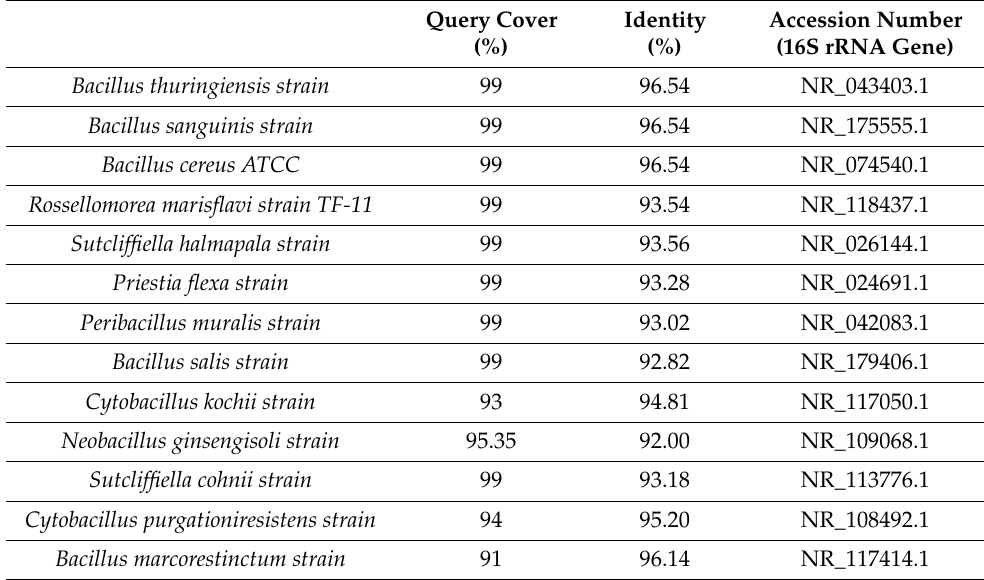
Table 4. A list of the bacterial species that were found on the anode electrode’s surface.